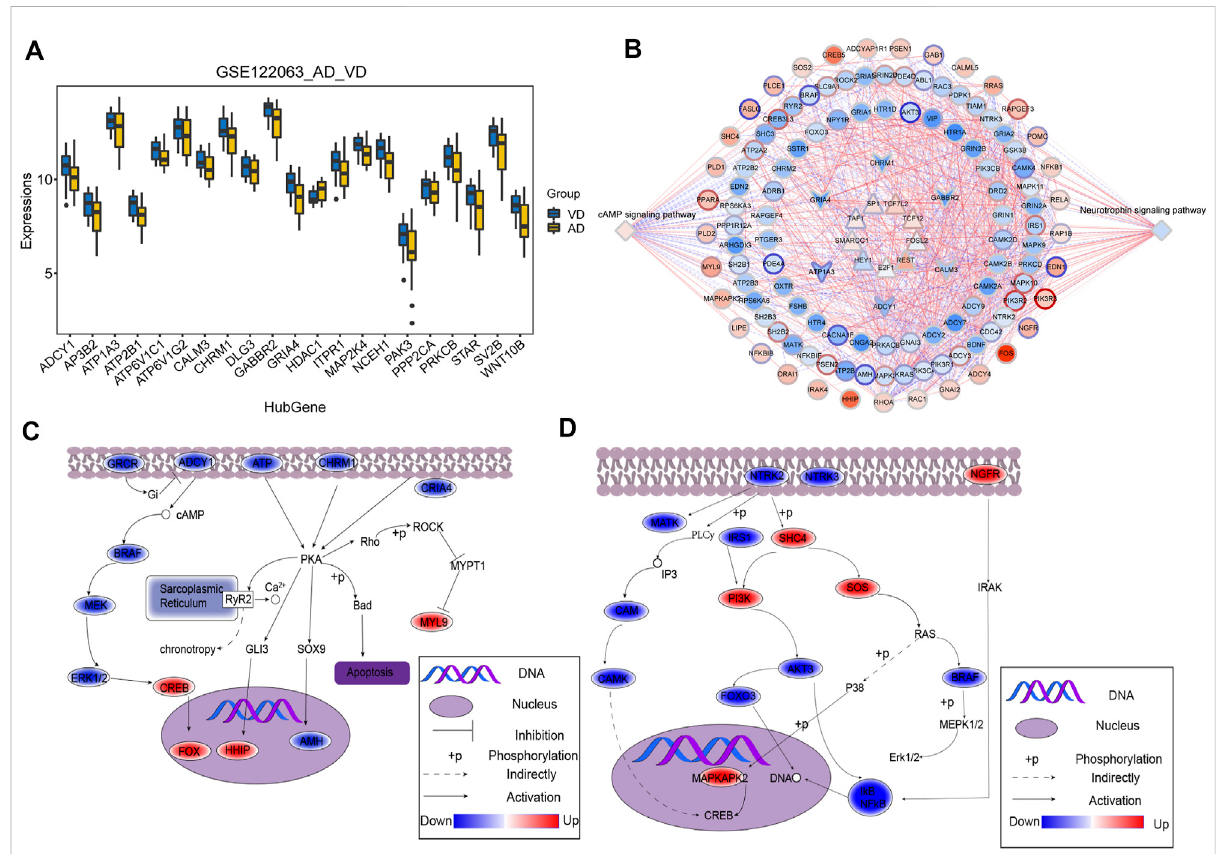
FIGURE 4 Integrated regulation of AD or VD by change in hub gene expressionof modules. (A) The expression of target genes in theGSE122063 data set. The thick black bar in the middle indicates the interquartile range, and the black line extending from it represents the 95% con fi dence interval. (B) Integrated regulatory network of cAMP signaling pathways and Neurotrophin signaling pathways. (C,D) Maps of gene-pathway correlations in both blue and turquoise module. AD, Alzheimer ’ s disease; VD, vascular